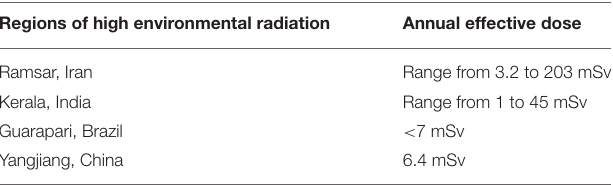
TABLE 3 | Estimated annual effective doses to persons living in areas of high natural radiation